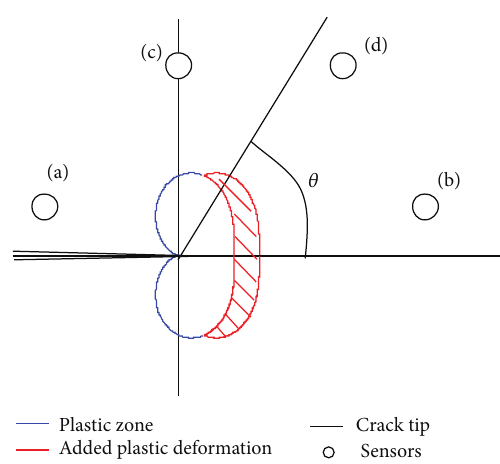
Figure 4: Sensor placement regions around a crack tip (a) receives lowest energy waves, (b) receives highest energy waves, and (c) receives lower energy waves compared to